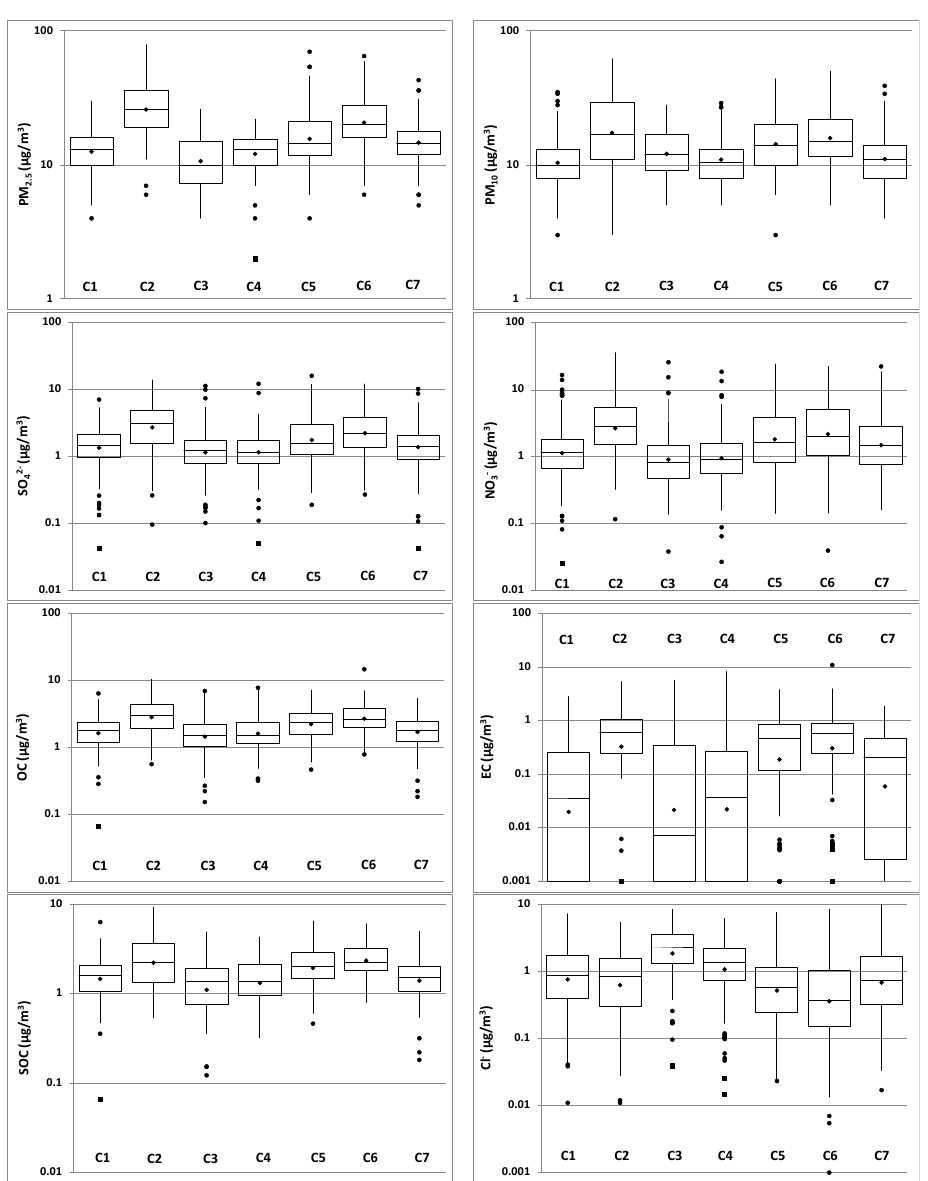
Fig. 6. Box plots for PM 2 . 5 , PM 10 , SO 2 −